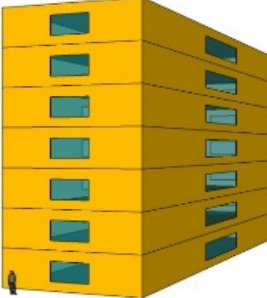
Figure 1. Building model.